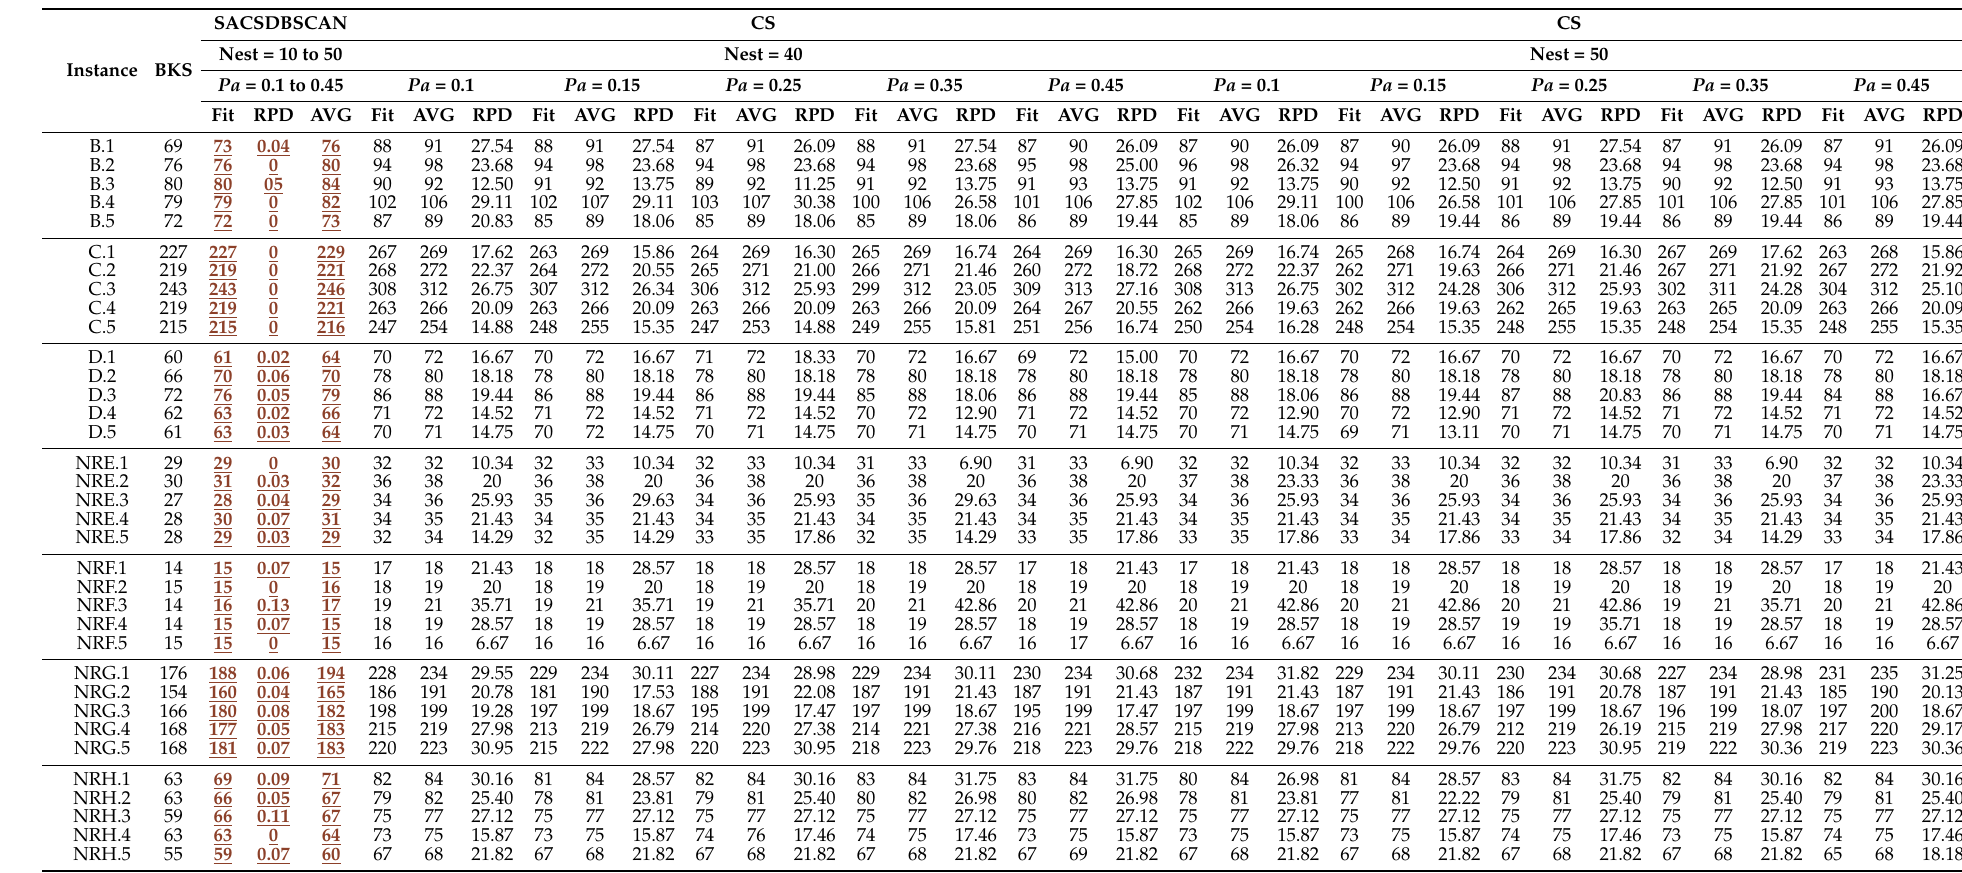
Table 8. Comparison results for set of groups B, C, D, NRE, NRF, NRG, NRH. SACSDBSCAN v/s CS Nest = 40,